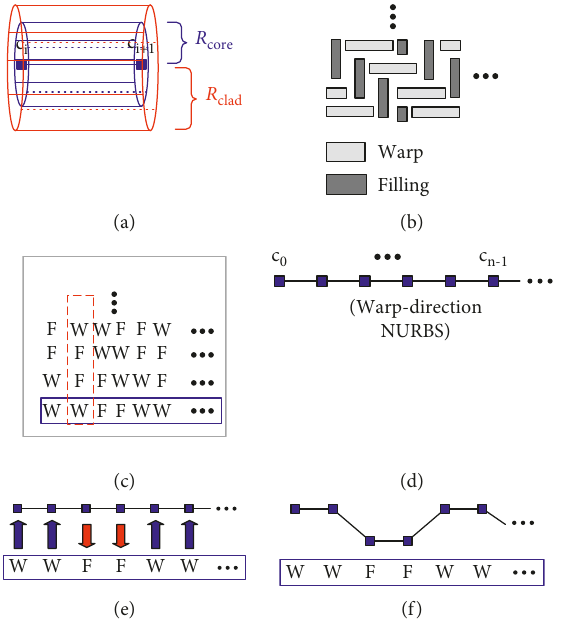
Figure 3: Procedure for weave structure modeling using NURBS. (a) Cylinder models for core and cladding representation [1]; (b) target fabric weave structure; (c) weave peg string input (dashed: weft, solid: warp direction); (d) initial NURBS control points (for warp); (e) adjustment of control points using peg string; (f) final crimp